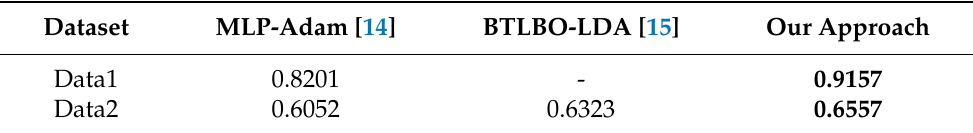
Table 19. Comparison of the proposed approach with similar studies in terms of